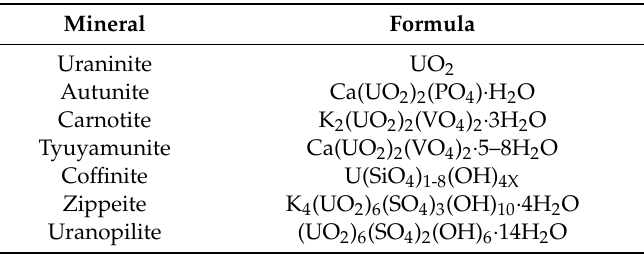
Figure 5. Location map for the samples used in this study. Table 1. Common Uranium